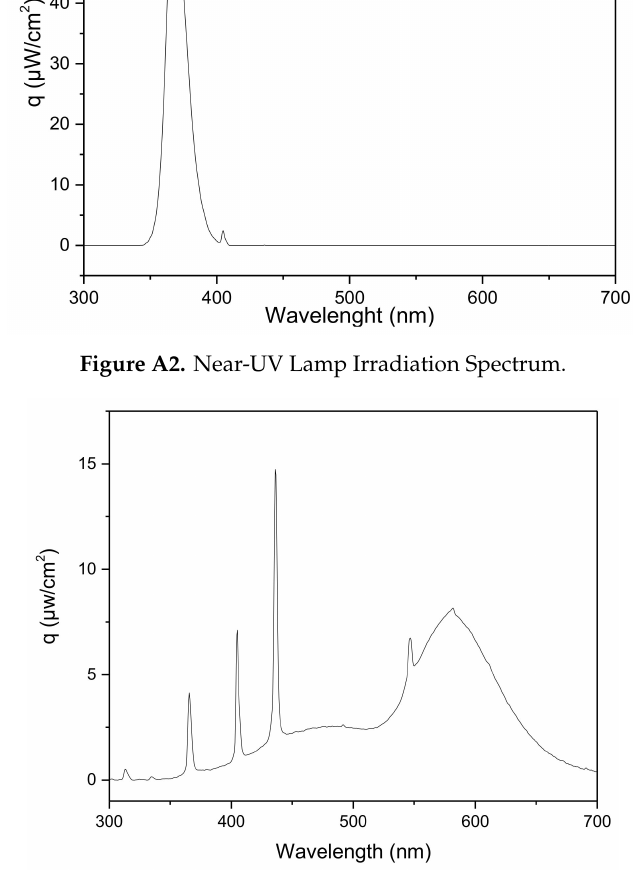
Figure A3. Visible Lamp Irradiation Spectrum.